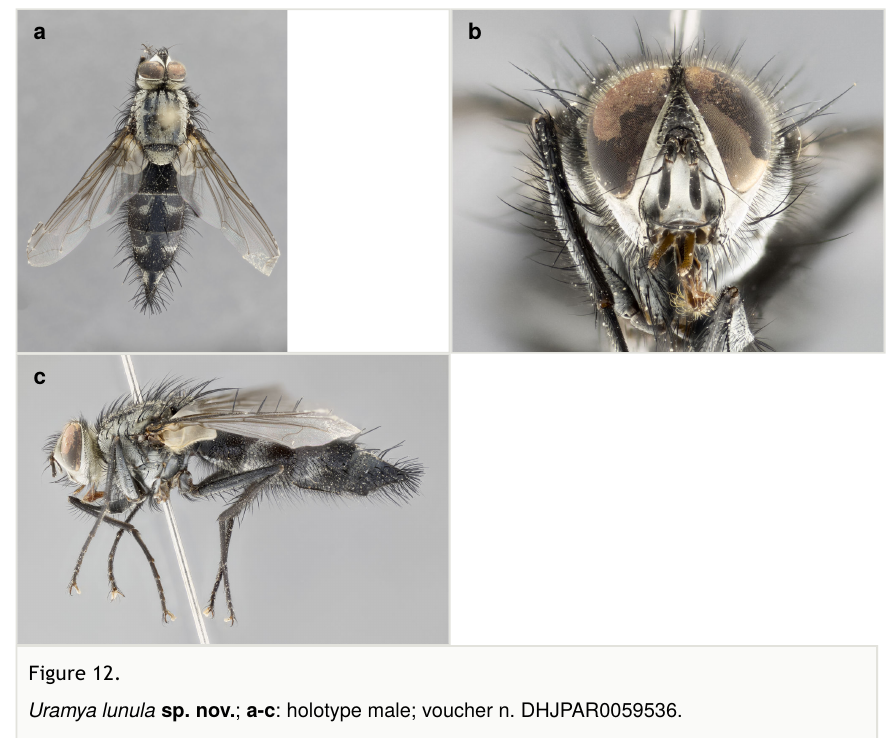
Figure 12. Uramya lunula sp. nov. ; a-c : holotype male; voucher n.